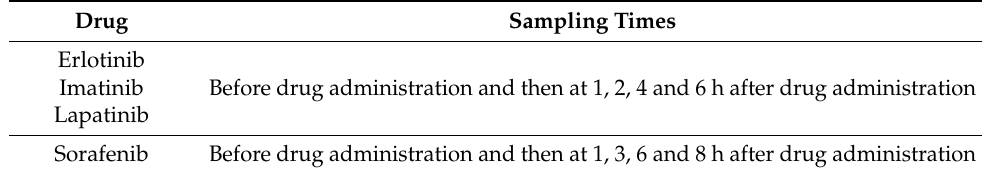
Table 1. Blood sampling times for monitored